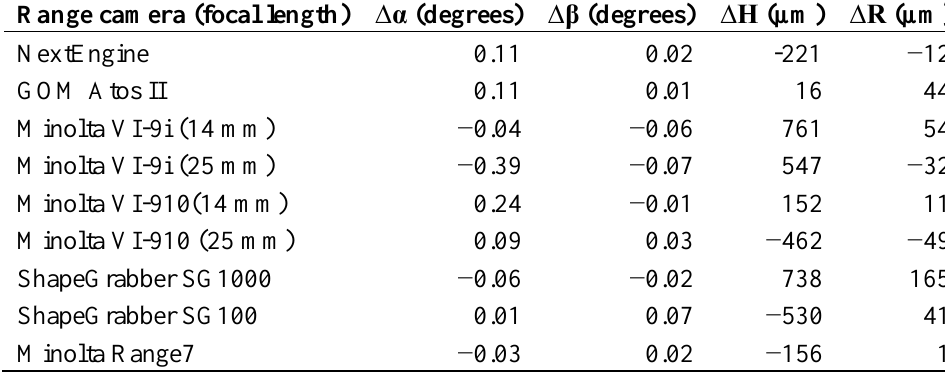
Table 6. Angular and linear accuracy report. Deviation between angles and linear dimensions (Radius and Height) evaluated by means of the CMM equipment, and corresponding angles and dimensions evaluated from planes fitted onto the primitives or extracted directly from the range